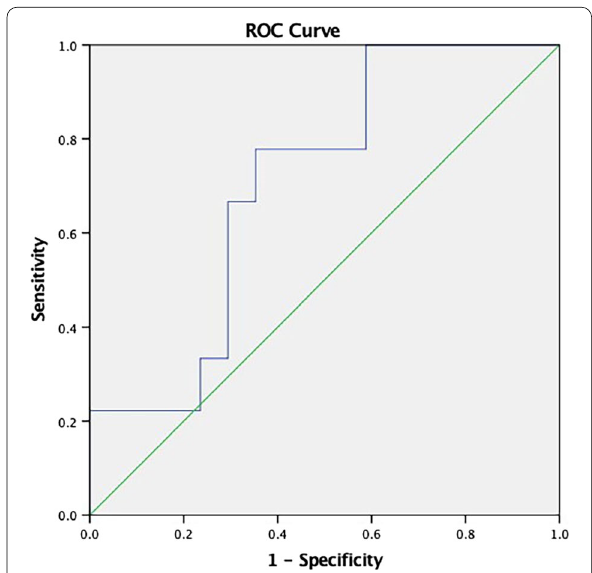
Fig. 8 Receiver operating characteristic curve (ROC)